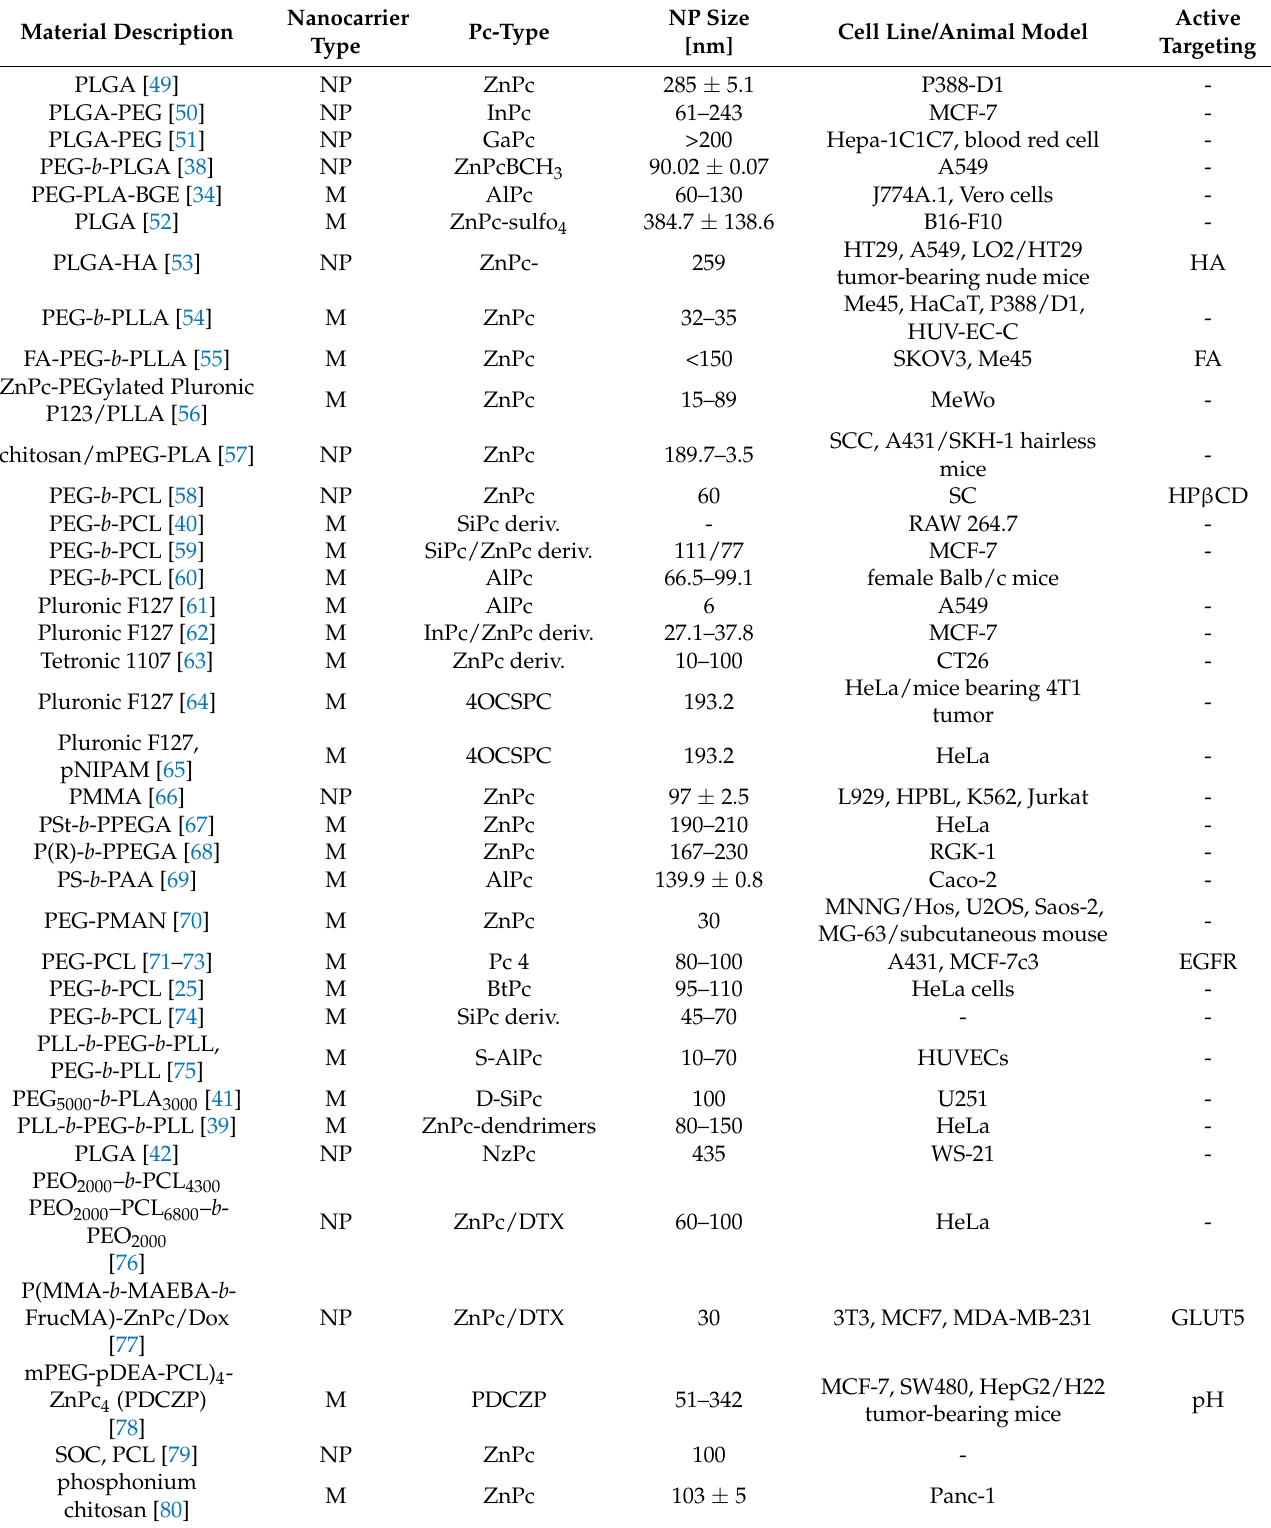
Table 2. The examples of Pc-polymer nanomedicines appearing in the literature since 2010 (M—micelle, NP—nanoparticle). Material